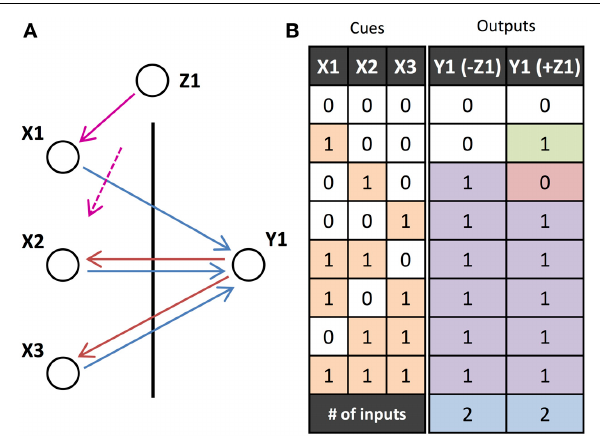
FIGURE 5 | Orchestrated Operations. (A) Motif performing an “OR” operation over the two input units X2 and X3 has the input unit X2 removed and X1 added by orchestrating feedback (magenta arrows) from unit Z1 which, like Y1, is initiated out-of-phase with the inputs. (B) Input-output table for the network in A. The input units (or cues), X1, X2, and X3, either receive feedforward input (1) or not (0), and the output unit Y1 is either activated (1) or not (0), in the cases where there is feedback or not from Z1. The final row indicates the number of inputs that the output unit’s operation depends on (relevant